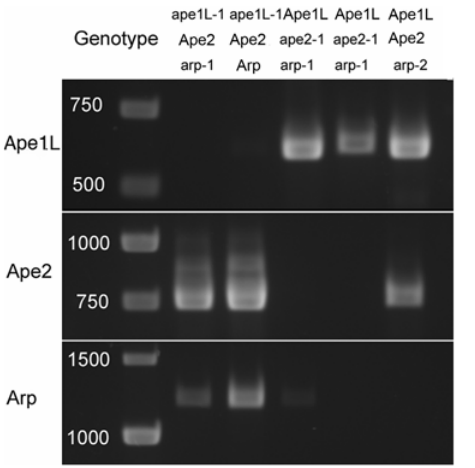
Figure 2. Expression of Ape1L (top), Ape2 (middle), and Arp (bottom) genes. RT-PCR used template RNAs extracted from a selection of strains. Genotype of each strain, indicated by PCR analysis of extracted DNA, is shown at the top. In each strain with a T-DNA insertion, ape1L-1 , ape2-1 , and arp-2 , accumulation of transcript of the corresponding gene was undetectable. RNA accumulation differed among the arp-1 base-substitution strains.